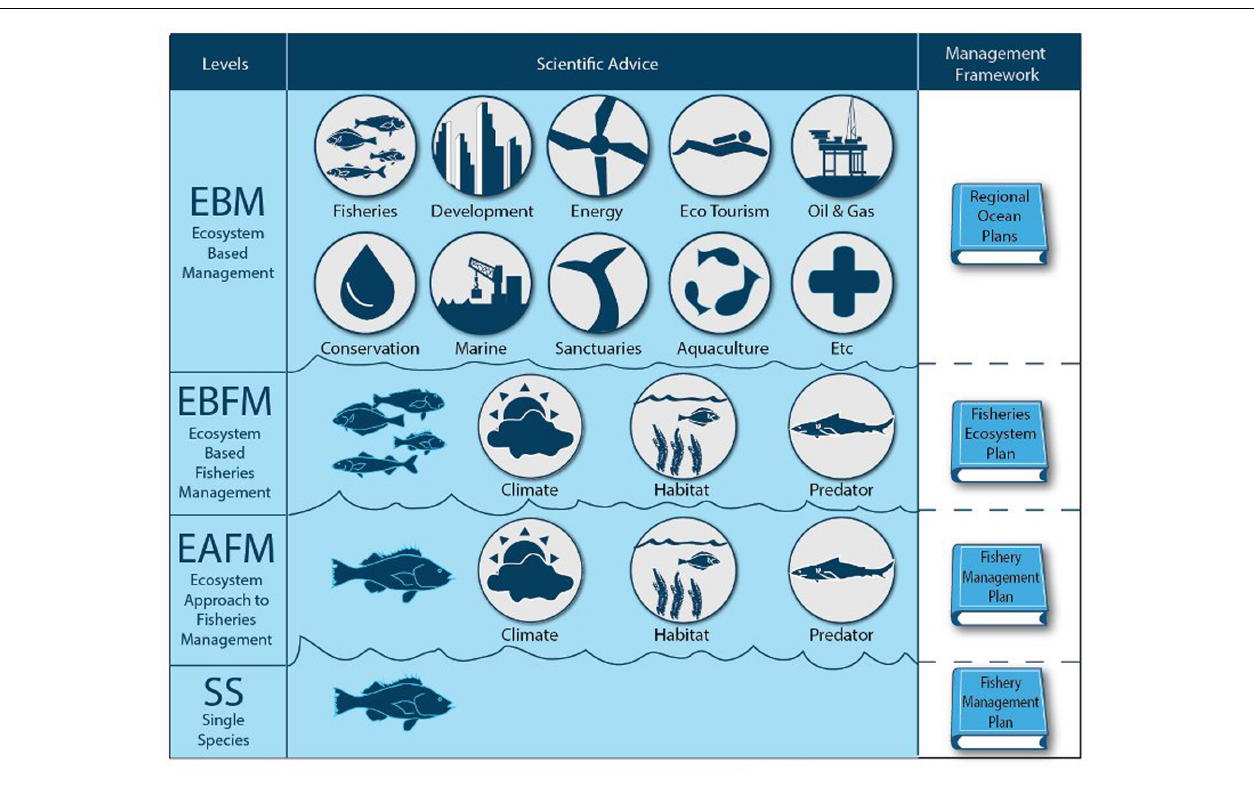
FIGURE 1 | From single stock to Ecosystem Based Management – after Dolan et al.